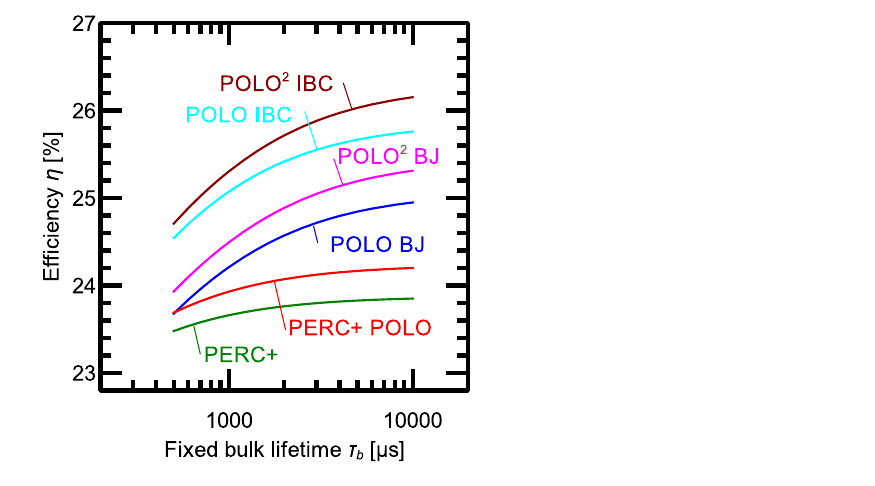
Figure 7. Conversion efficiency for the cell structures based on p-type Si discussed in this work as a function of an injection-independent bulk SRH